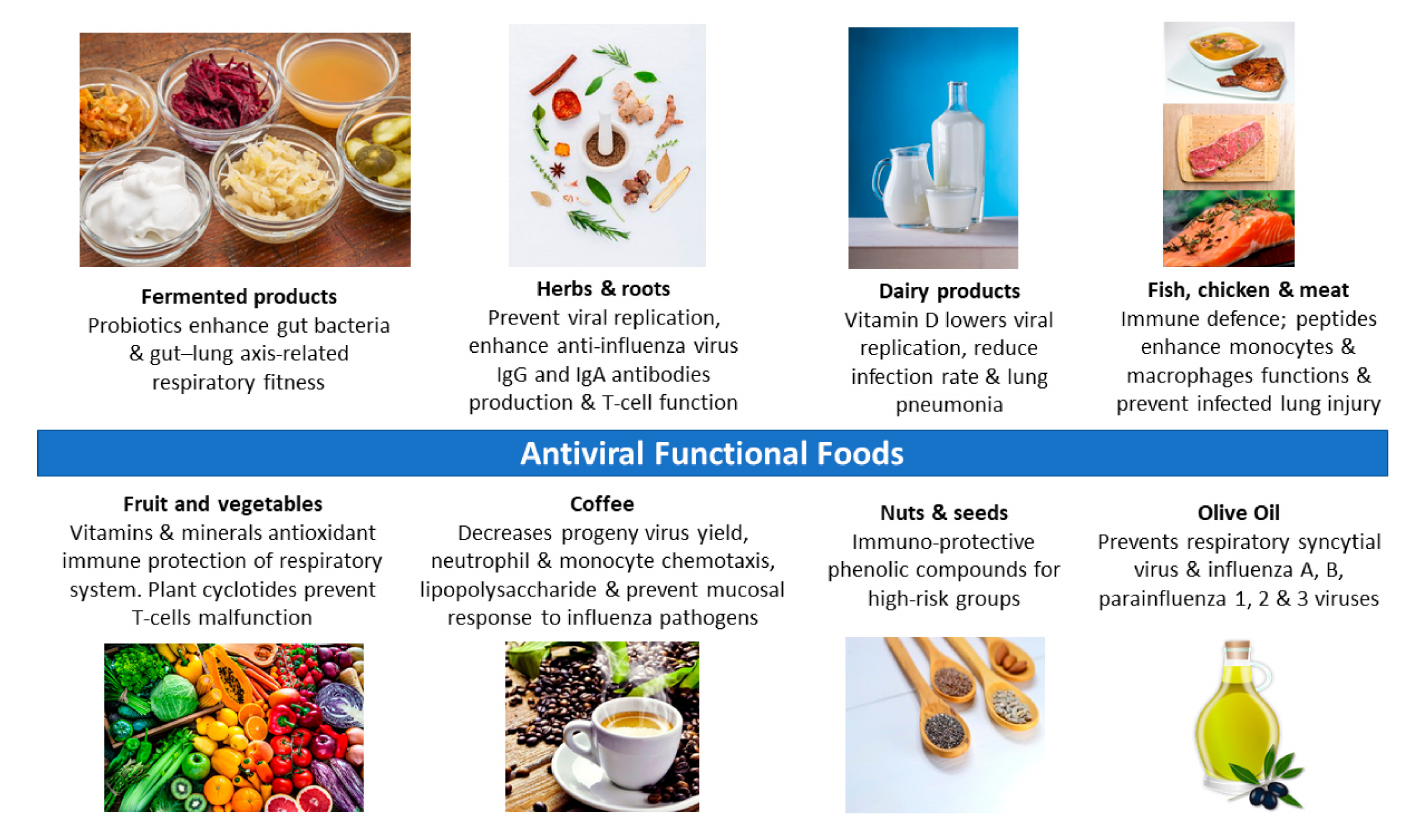
Figure 1. Functional foods and antiviral mechanisms to optimize